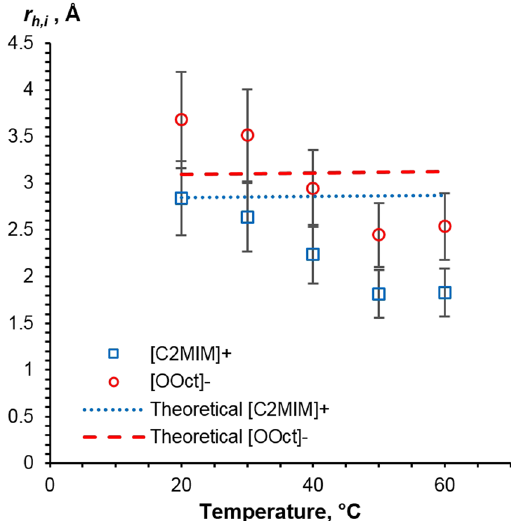
Figure 5. Stokes-Einstein radii of the cation and anion in [C 2 MIM][OOct] as a function of temperature (points), as follows from Fig. 4b and Eq. 4. Dashed lines correspond to cation and anion sizes calculated from Eq.